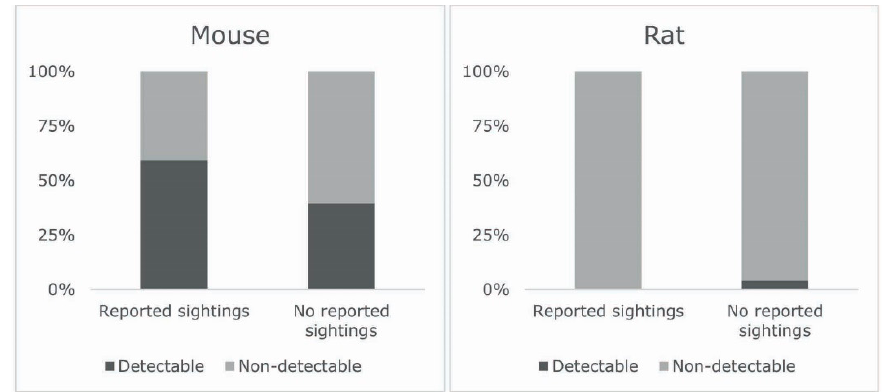
Figure 2. Prevalence of detectable allergens in study participants’ homes stratified by reported mouse or rat